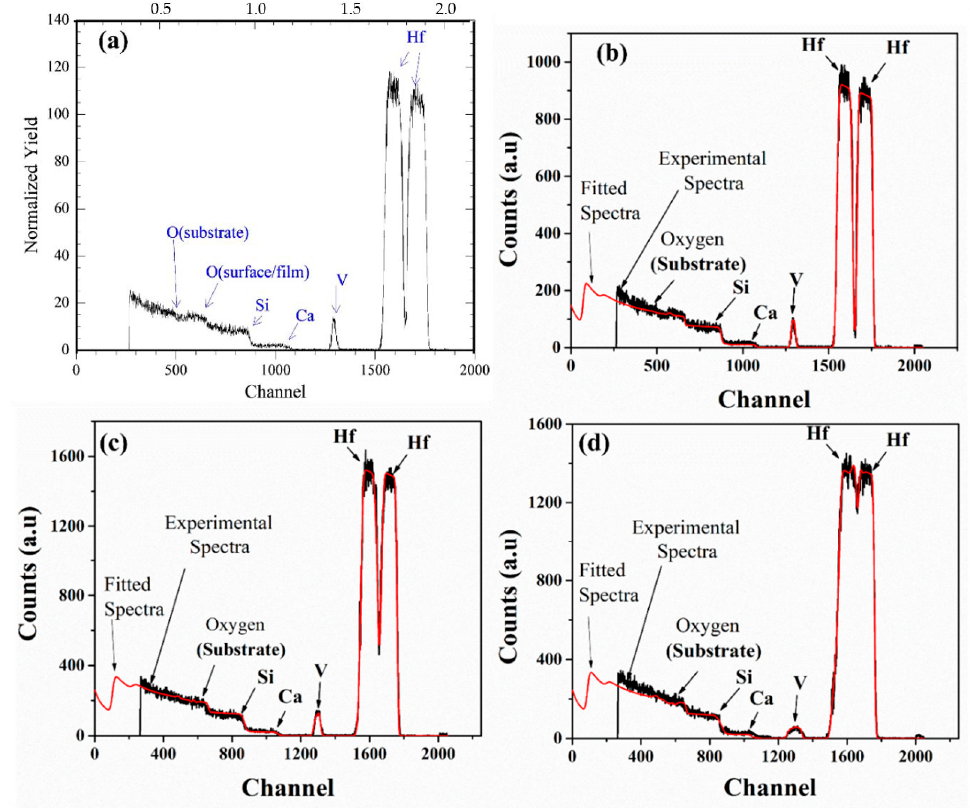
Figure 5. ( a ). Fitted and experimental RBS spectra of nanostructured multi-layered HfO 2 /V 2 O 5 /HfO 2 coatings: ( b ). as-deposited; ( c ) annealed at 300 °C; and ( d ) annealed at 400 °C.